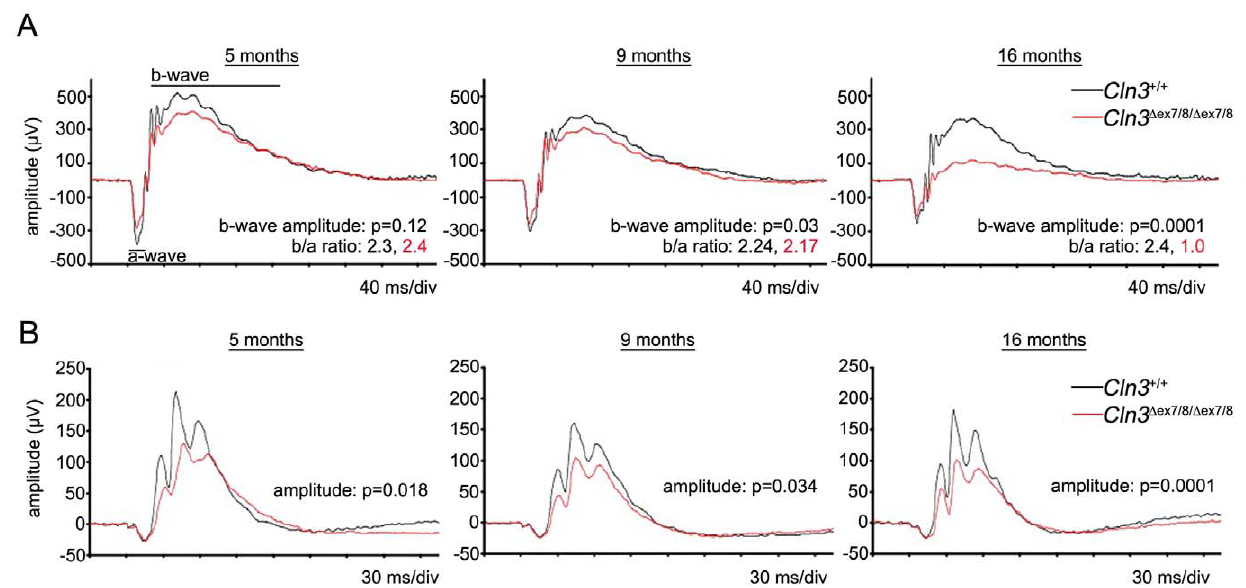
Figure 2. Electroretinography of 16-month-old Cln3 D ex7/8 mice. (A) Scotopic ERG traces are shown for 5-, 9-, and 16-month old wild-type ( Cln3 + / + , black trace, n=7) and homozygous Cln3 D ex7/8 ( Cln3 D ex7/8/ D ex7/8 , red trace, n=8) mice. The relative amplitudes of the a-wave do not dramatically differ between the wild-type and homozygous Cln3 D ex7/8 mice. However, the b-wave is drastically reduced in aged homozygous Cln3 D ex7/8 mice, compared to wild-type littermates. Thus, homozygous Cln3 D ex7/8 mice exhibit an electronegative ERG at 16-months of age (b/a ratio=1, versus b/a ratio=2.4 in wild-type mice). (B) Photopic ERG traces, reflecting cone response, are shown for 5-, 9-, and 16-month-old wild-type ( Cln3 + / + , black trace, n=7) and homozygous Cln3 D ex7/8 ( Cln3 D ex7/8/ D ex7/8 , red trace, n=8) mice. There was a significant genotypic difference in the relative mean amplitudes already at 5 months of age.